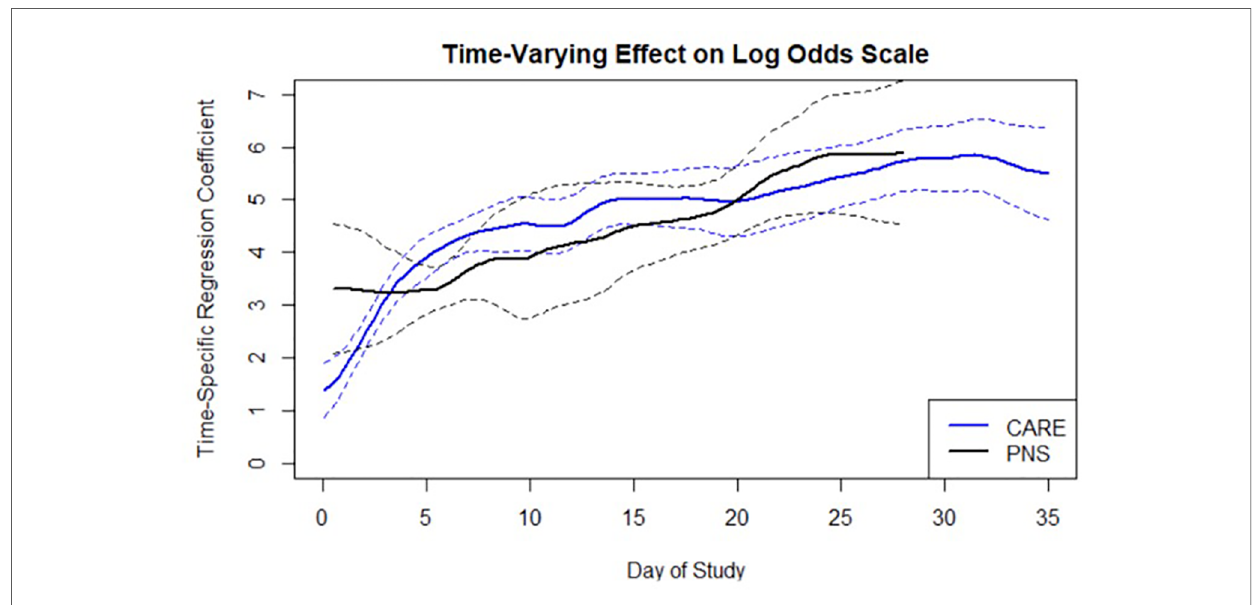
FIGURE 4 Time-varying relationship between response to current prompt and average prompt response rate prior to current